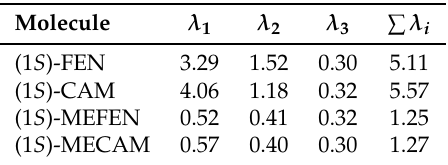
Table 3. IR Intensity Carrying Modes (ICM)s of the four chiral compounds for which the corresponding simulated and experimental spectra are reported in Figures 6 and 7. The APTs and AATs required for the evaluation of ICMs have been computed at the B3LYP/aug-cc-pVTZ level of theory. All numerical data are given in the atomic units of the M IR